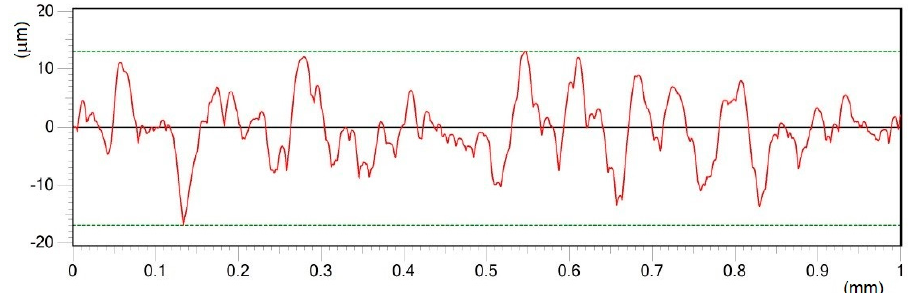
Figure 6. Roughness profile of surface A in Y direction treated by pulse energy of 0.2 mJ; Ra 2.18 μ m.